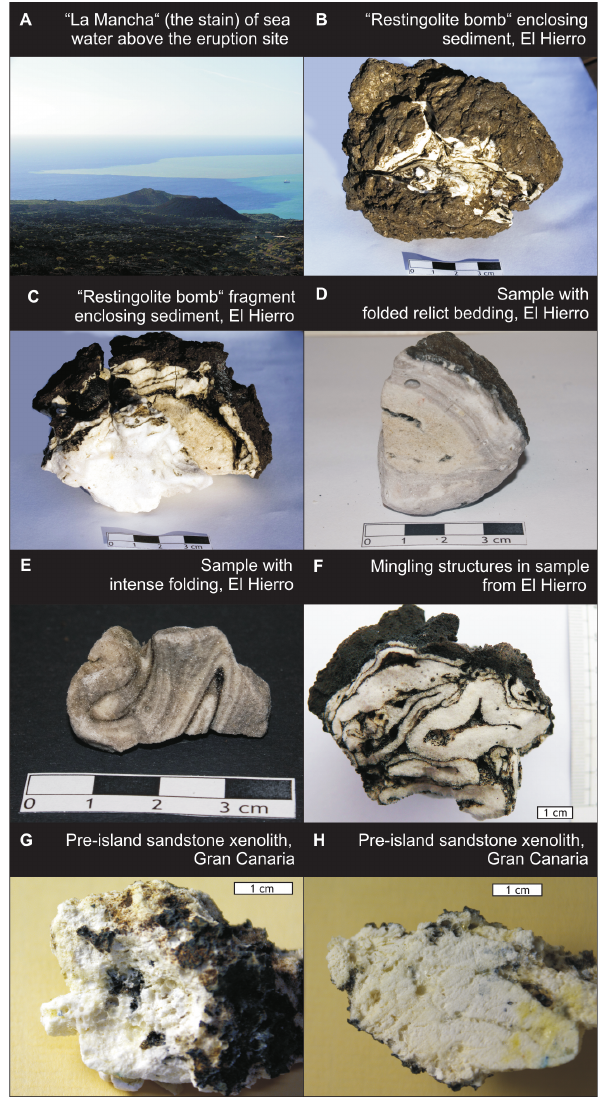
Fig. 2. Overview of features of “restingolites” from El Hierro. (A) Ocean surface above the offshore eruption. Note the changed colour of the water (locally referred to as “la mancha”, i.e. “the stain”) that occurred early during the eruption. (B–F) Samples dis- playing typical textural features, such as a crust of basanite, primary sedimentary bedding, folded bedding and schlieren, high vesicu- larity, and mingling structures. (G and H) “Xeno-pumice” sam- ples from Gran Canaria that resemble El Hierro “restingolites” and which have been demonstrated to originate from pre-island sand- stone layers. For additional sample images see Appendix Fig. A1.